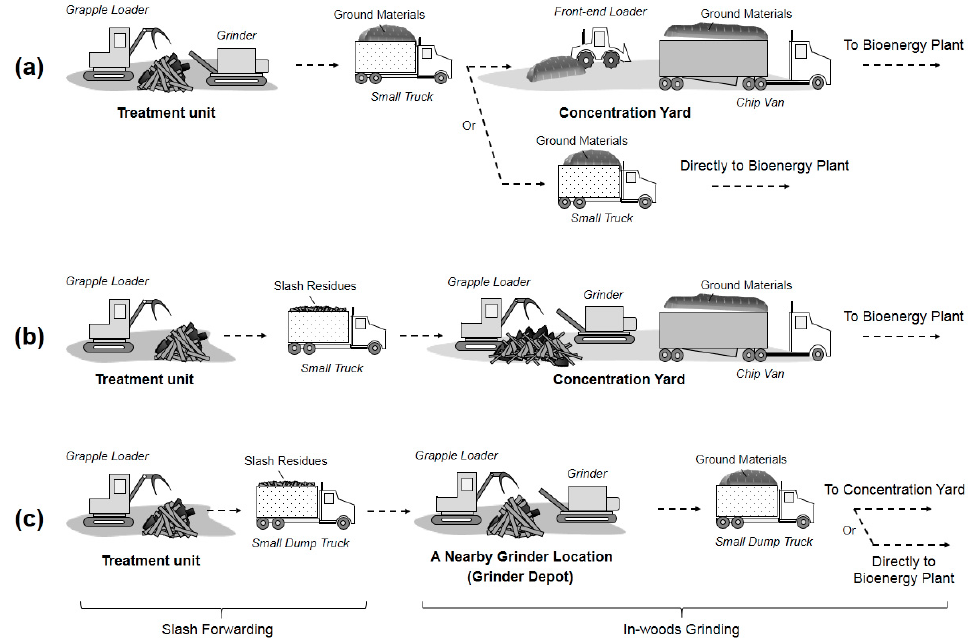
Figure 1. In-woods grinding ( a ), slash forwarding ( b ), and a combination system of both options ( c